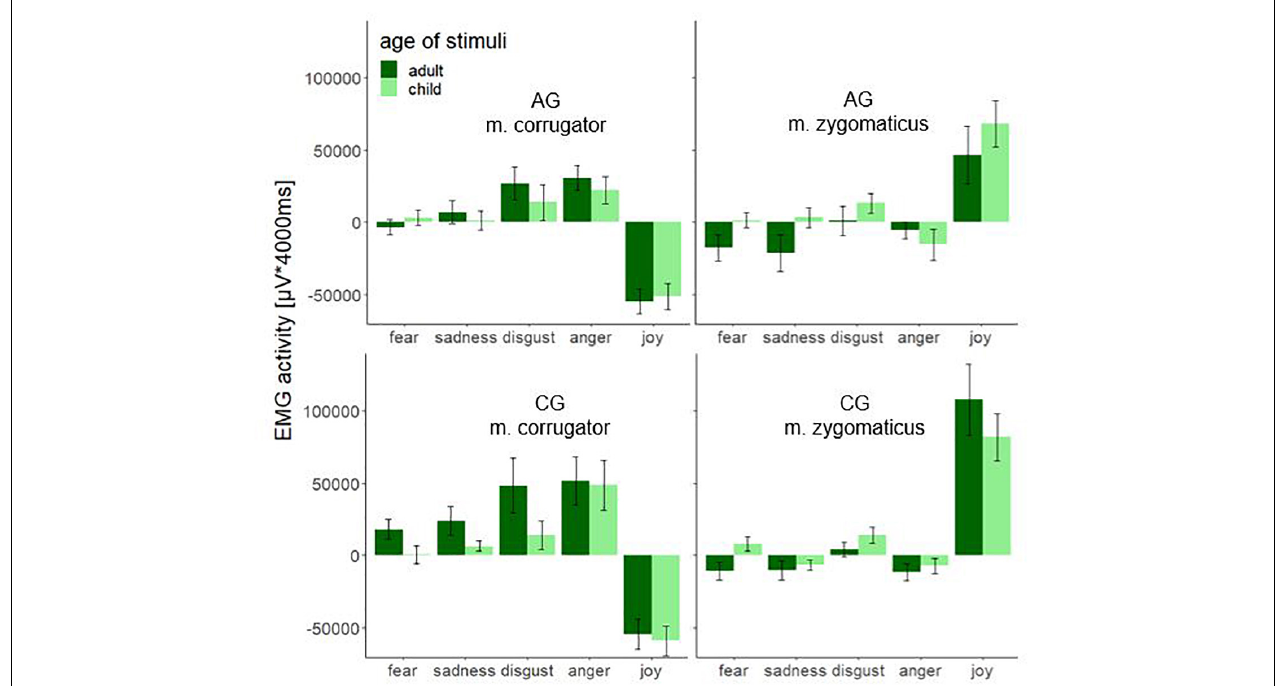
FIGURE 5 | Electromyographic activity ( µ V × ms) over entire measurement interval (0–4000 ms) for the interaction effect consisting of the within-subject factors age (adult and child) and emotion (fear, sadness, disgust, anger, and joy) separated by muscle (m. corrugator and m. zygomaticus) and group (AG and CG). Negative EMG activity is caused by the baseline correction; error-bars represent the standard error.